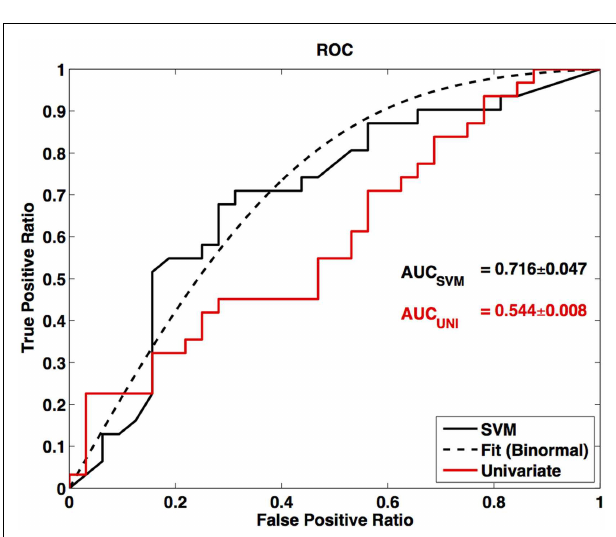
FIGURE 6 | Receiver-operator curve for LOOCV SVM and ROC for univariate node counting . Smooth curve is a binormal (Cai and Moskowitz, 2004) fit to the LOOCV SVM ROC. AUC is calculated from binormal